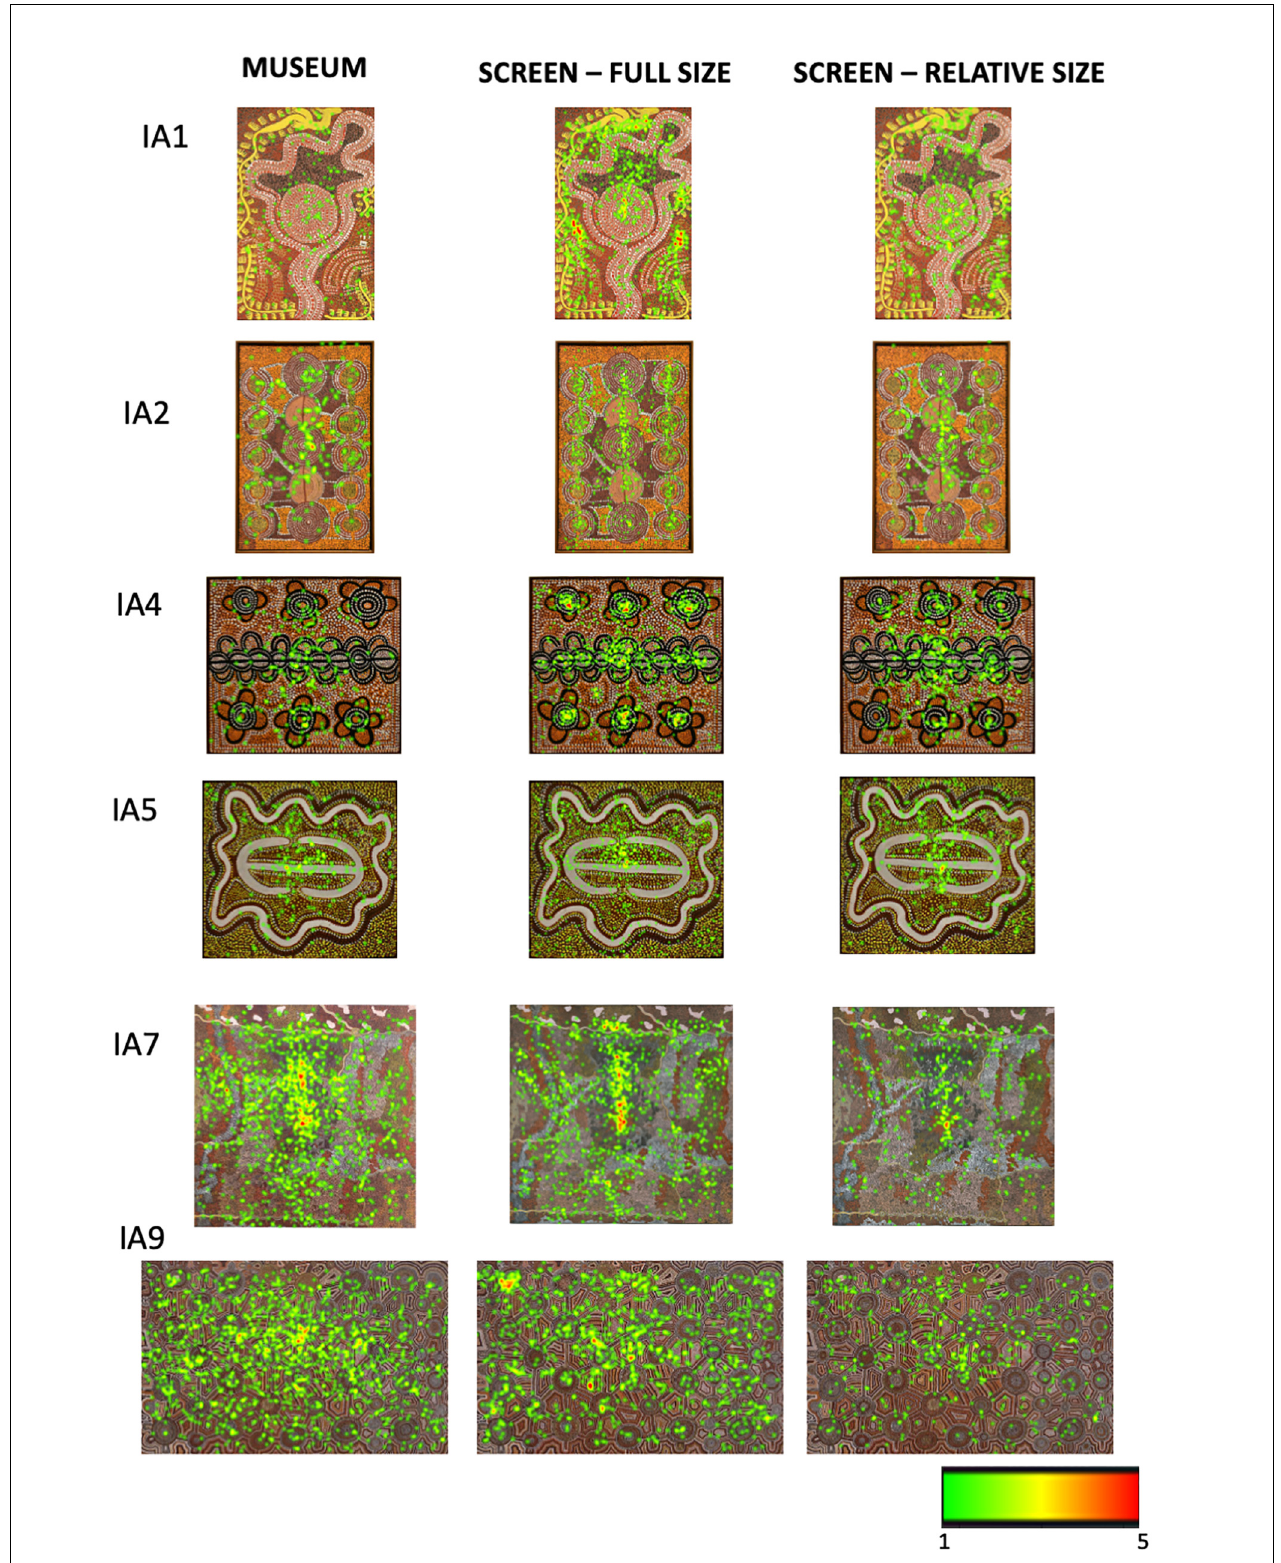
FIGURE 11 | The heatmaps of total fixation counts for some of the Indigenous Australian paintings in the three viewing conditions. See Supplementary Material for the heatmaps for all Indigenous Australian paintings.